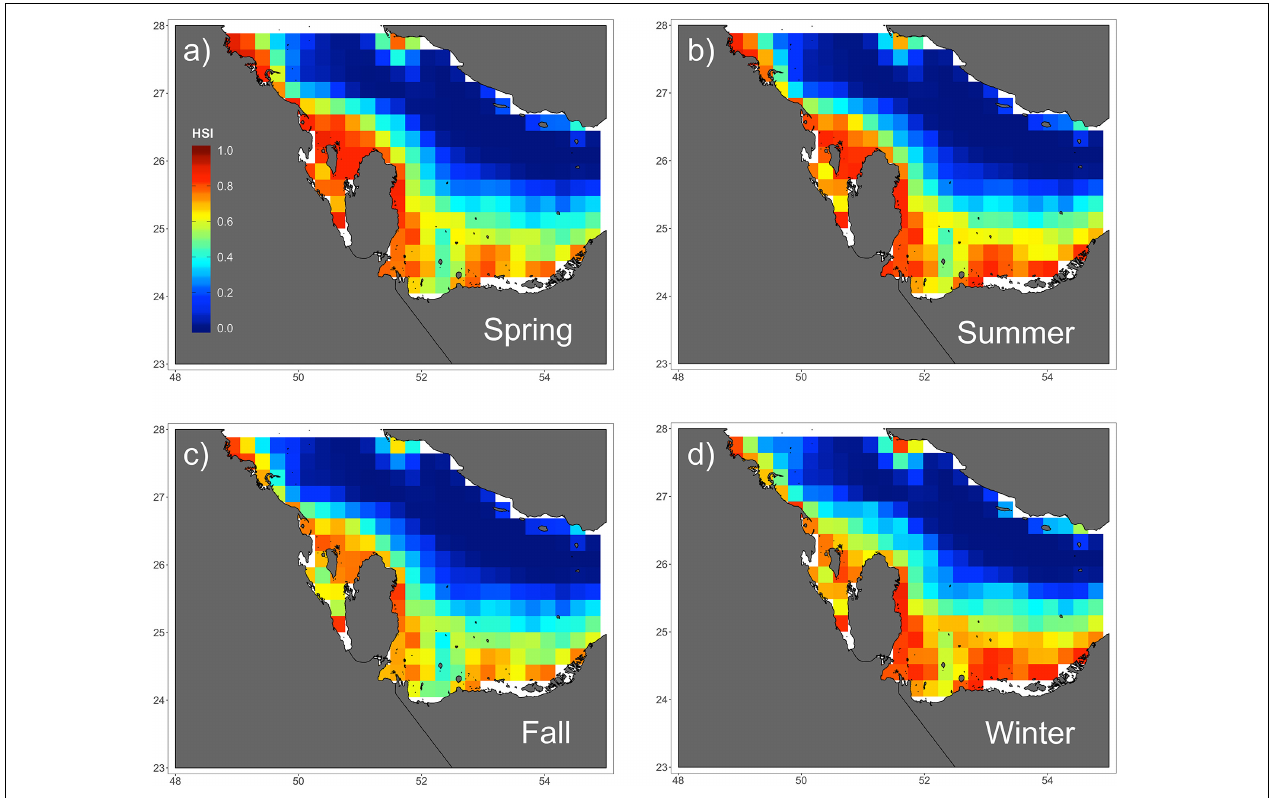
FIGURE 4 | Seasonal predictions of habitat suitability (range: 0–1) for hawksbill turtles in the Arabian Gulf for (a) spring, (b) summer, (c) fall, and (d) winter. Spatial predictions of habitat suitability index (HSI) is shown across seasons based on the species distribution GAMM. There are slight variations among seasons, but all show high suitability along the southern coastline where there is shallow water.